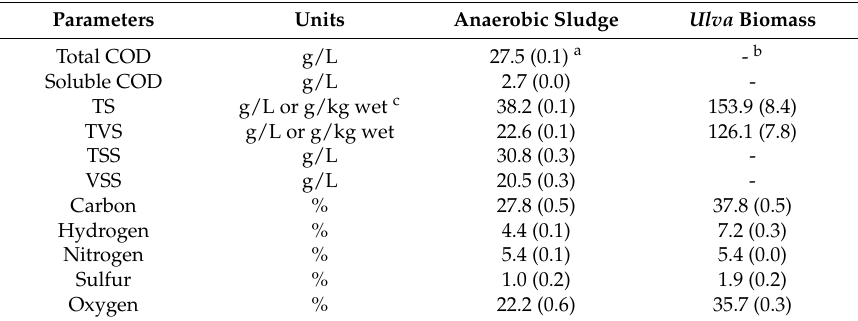
Table 1. Physicochemical characteristics of the inoculum and substrate